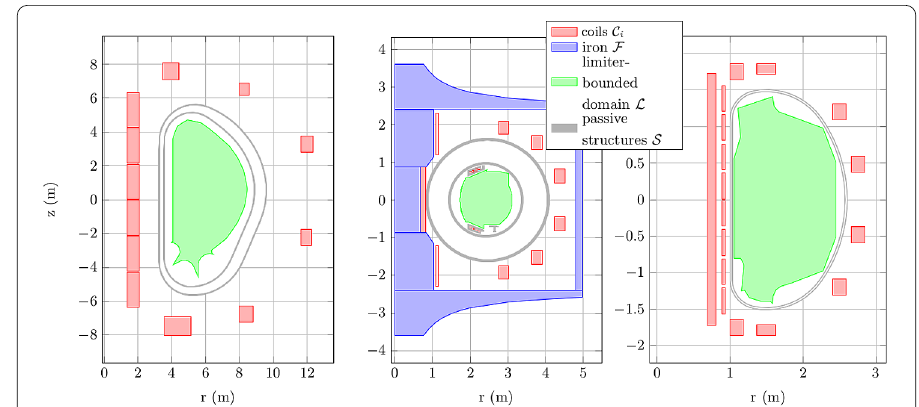
Figure 4 Poloidal section of the tokamaks ITER (left), WEST (middle) and HL-2M (right). ITER, the International Thermonuclear Experimental Reactor, is currently build in Cadarache, France and planned to be operational in 2015. WEST, the Tungsten (W) Environment in Steady-state Tokamak, is the remodeled Tore Supra tokamak of the CEA, also located in Cadarache. Tora Supra was operational from 1988–2010 and experiments with WEST started in 2017. HL-2M is a modification of HL-2A, a tokamak in Chengdu, China operational since